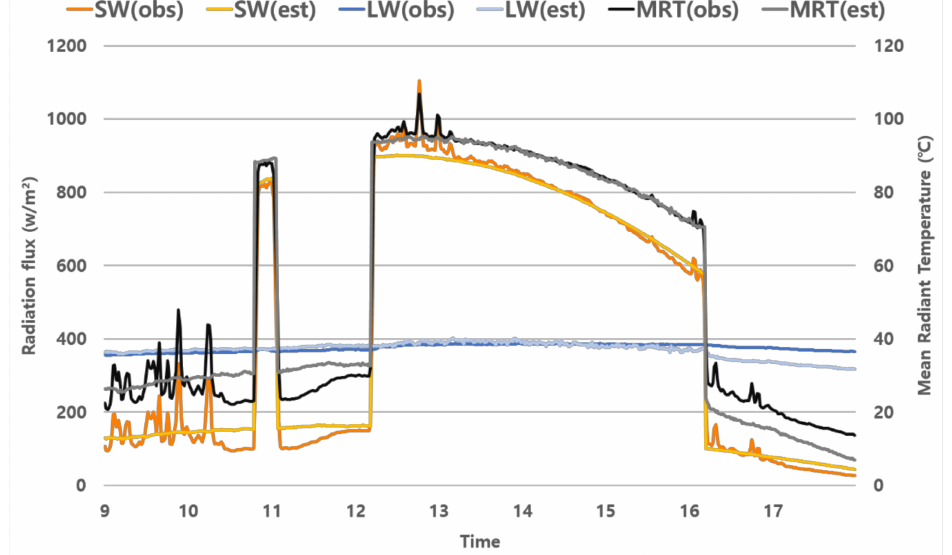
Figure 4. Comparison between estimated shortwave, longwave radiation, MRT and data measured in Korea over hourly. Orange, yellow line is incoming shortwave radiation, blue line is incoming longwave radiation, black, gray line is